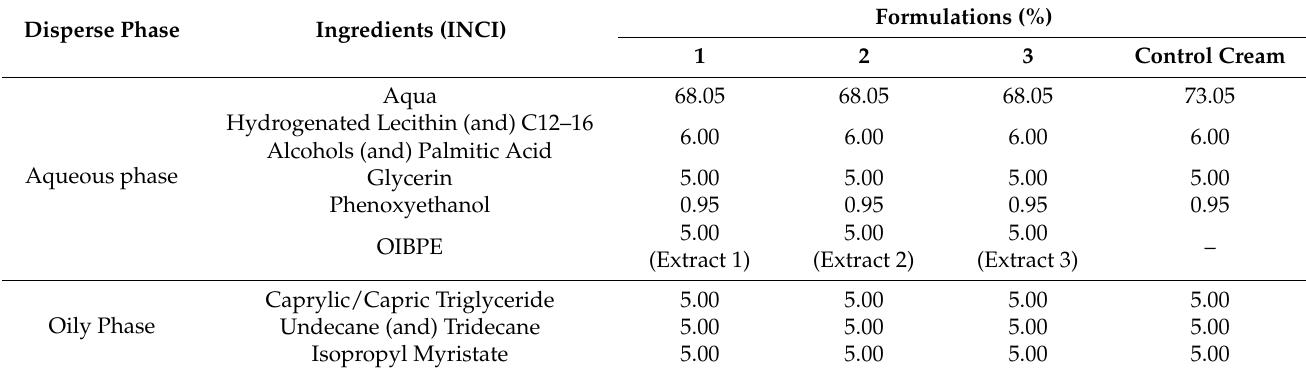
Table 2. Qualitative and quantitative compositions of the oil-in-water (O/W) creams. Disperse Phase Ingredients (INCI)